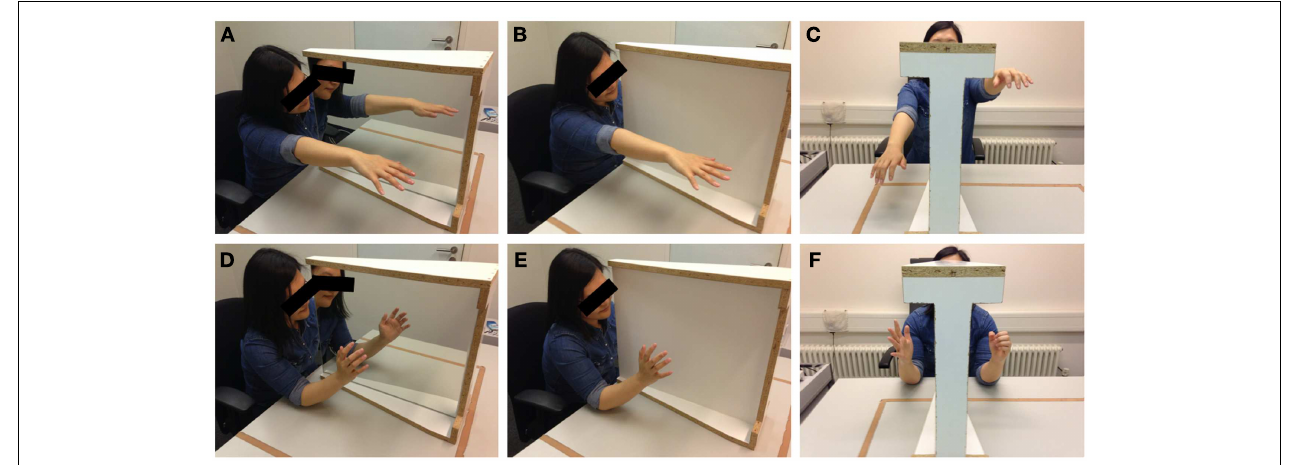
conditions as well as the range of incongruent movements (C,F) for the arm (A–C) and hand (D–F) conditions. Photographs taken by author Robin